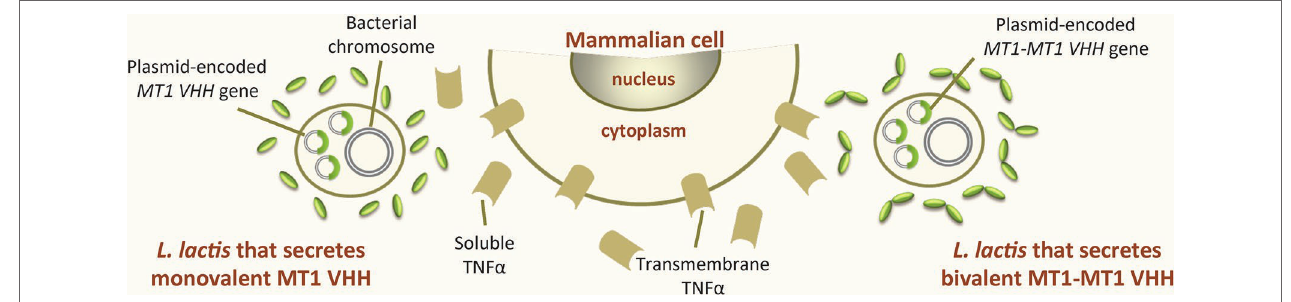
FIGURE 1 | Recombinant LAB that produce VHH against intestinal inflammatory bowel diseases. Recombinant Lactococcus lactis strains secreting either monovalent MT1 or bivalent MT1-MT1 VHH against TNF α , an inflammatory cytokine involved in inflammatory bowel disease. The gene encoding MT1 VHH is constitutively expressed within a replicative plasmid either as a single copy (monovalent form, MT1 VHH) or as two copies in tandem (bivalent form, MTI-MT1